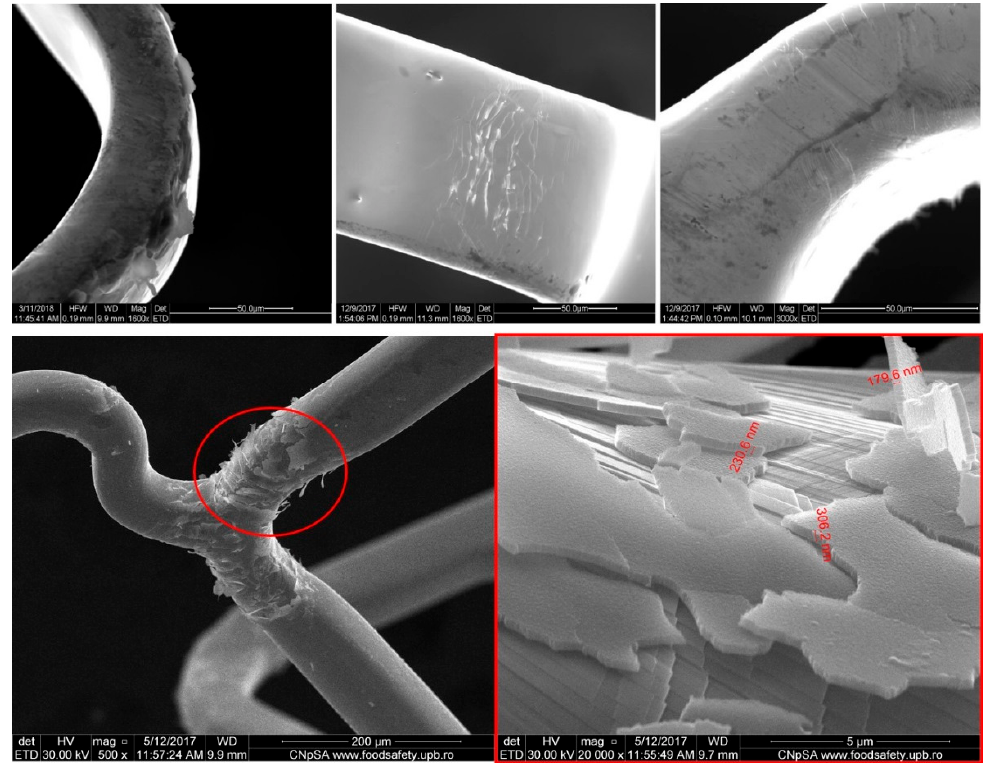
Figure 5. Inflated titanium oxynitride coated stent with coating flaws visible on all crowns (cracks, delamination, and possible peeling off in selected areas).